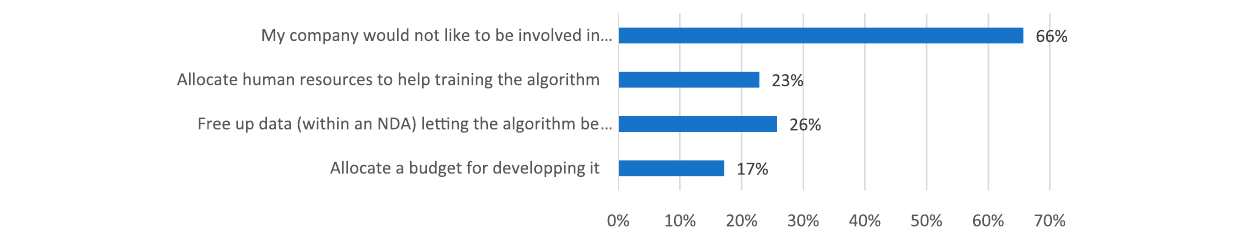
FIGURE 5 | Stated preference regarding the type of resource allocation for AI solutions.